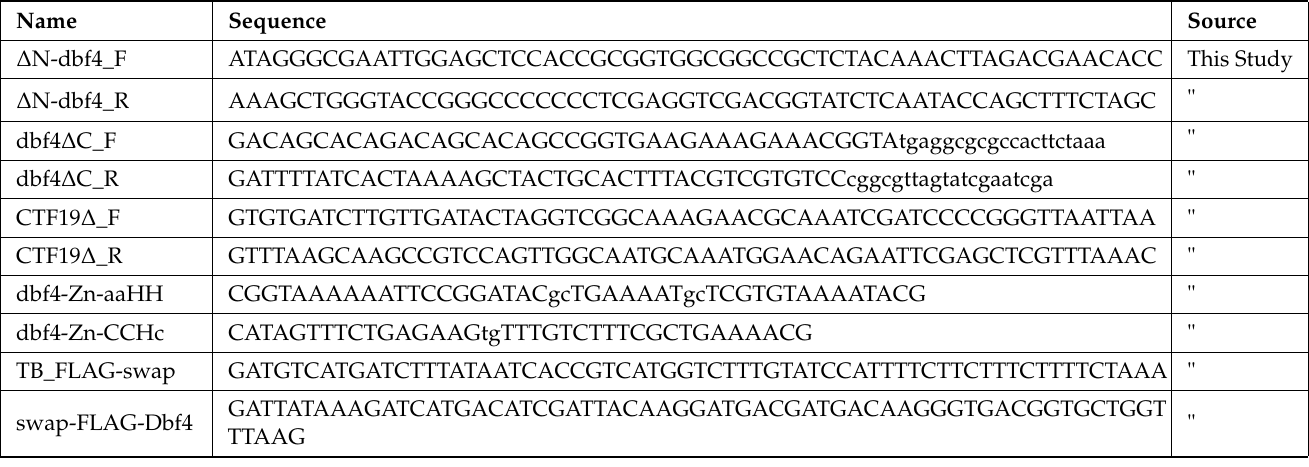
Table 1. Sequences of DNA oligonucleotides used in this study. Oligonucleotides were obtained from International DNA